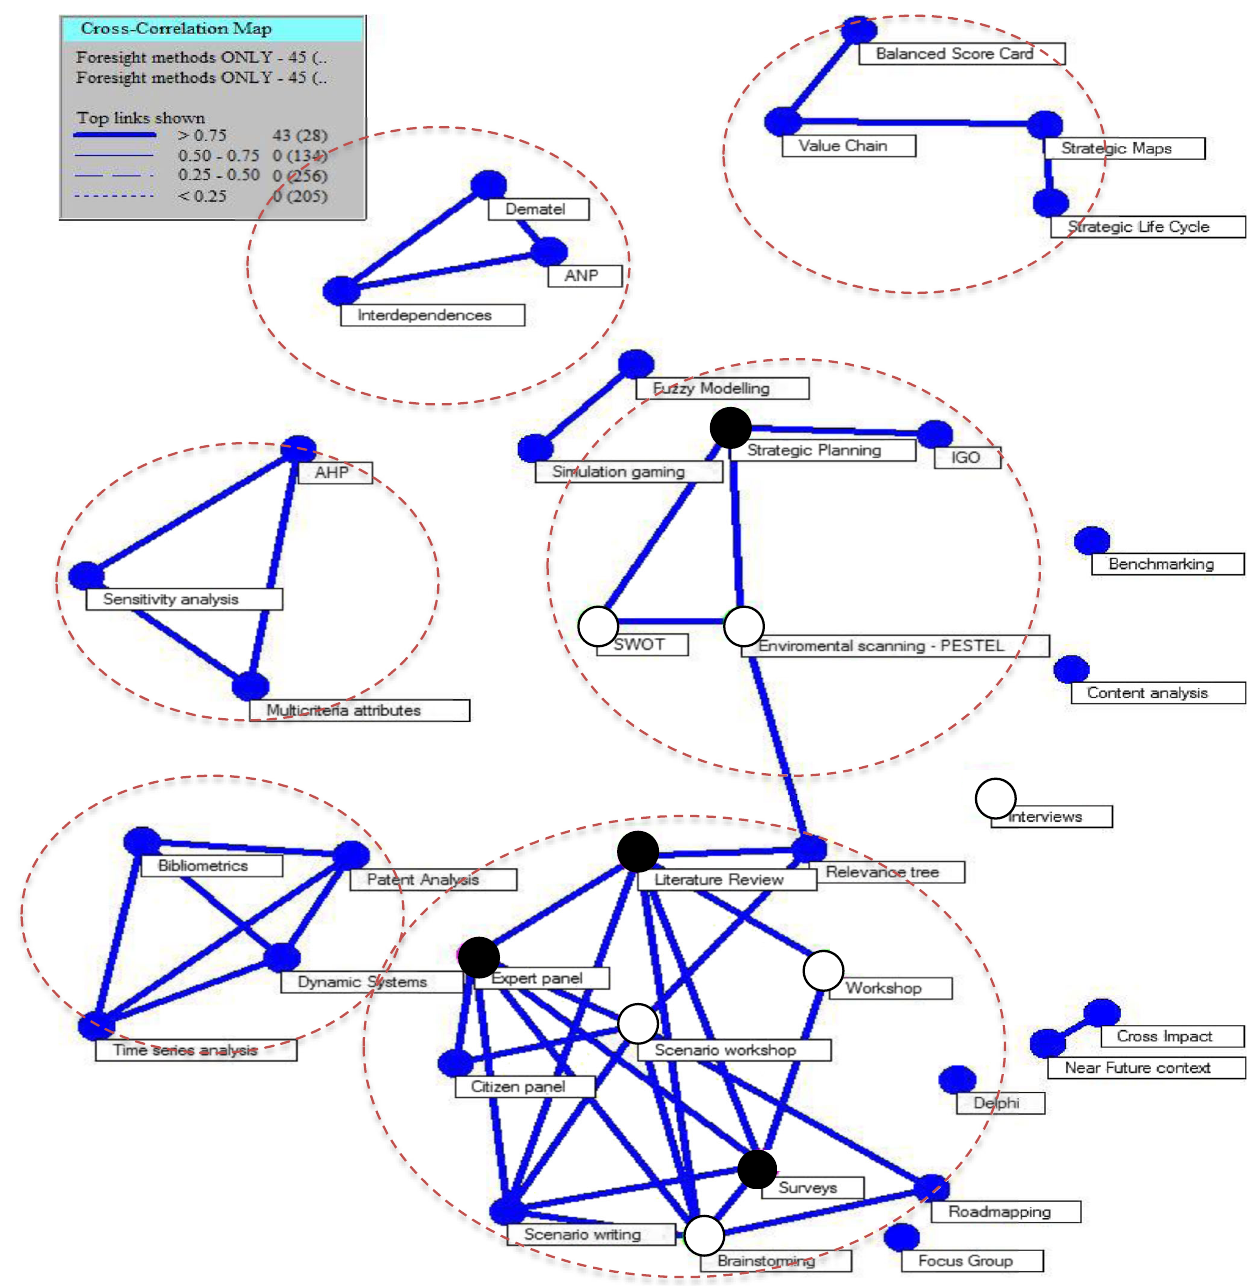
Fig. 6 Relationships between foresight